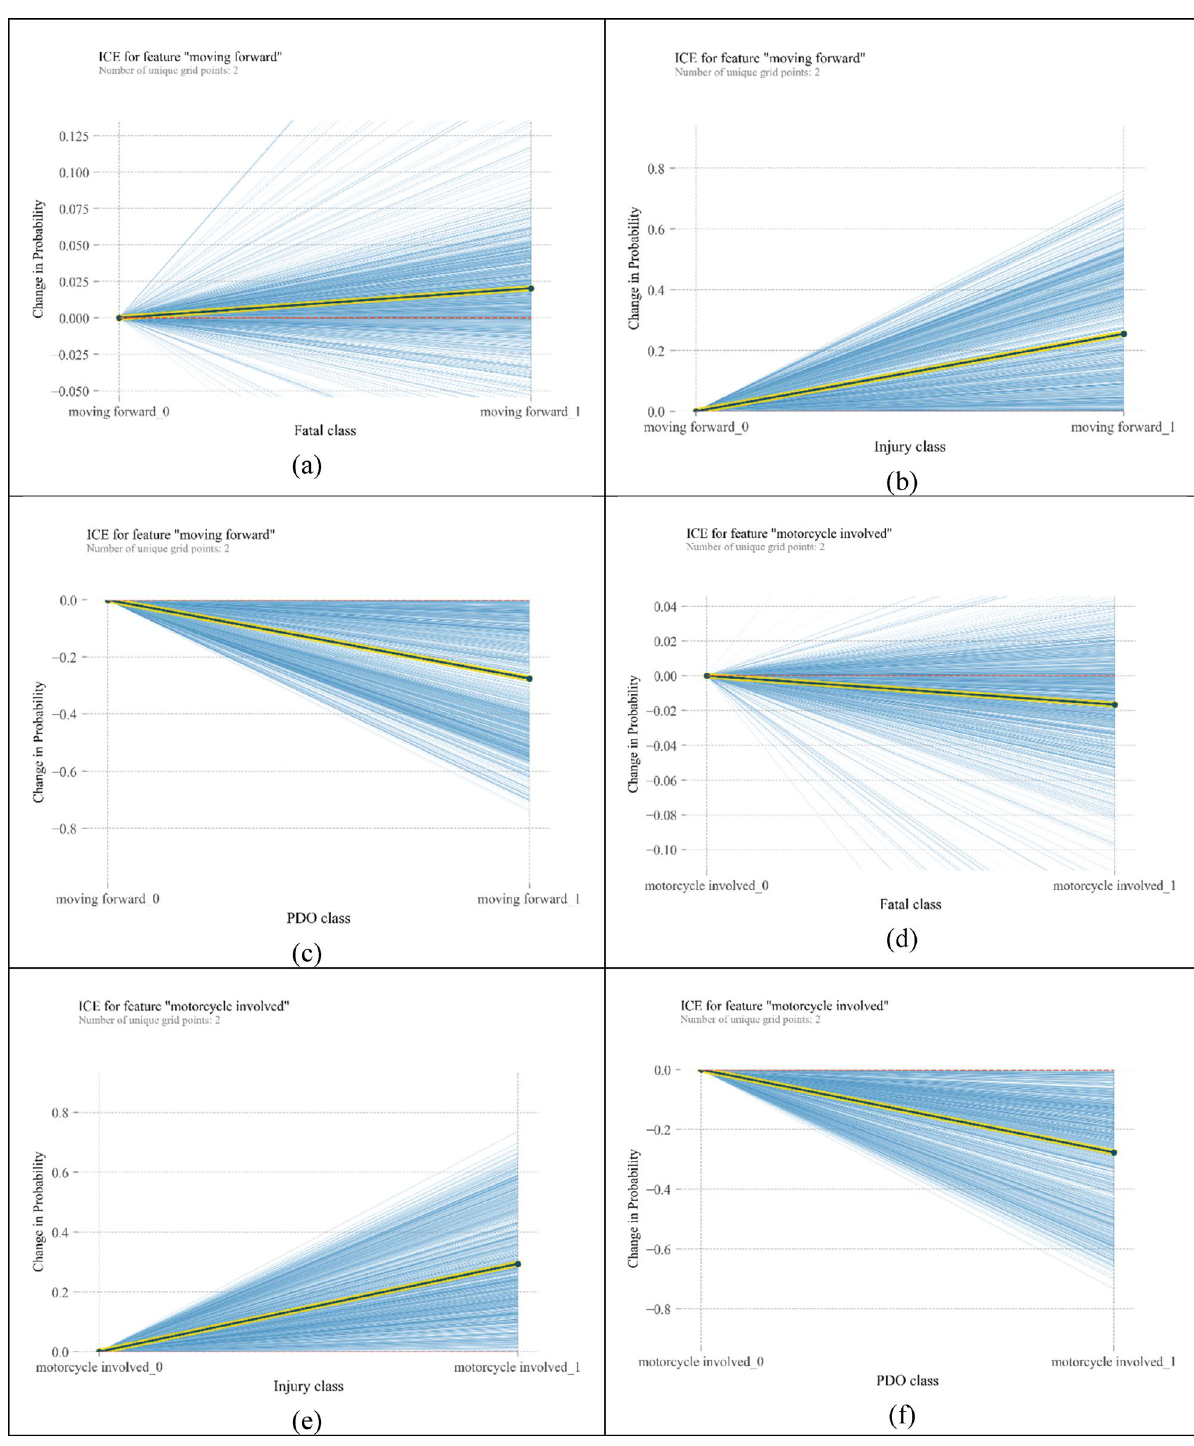
Figure 6. ICE plots for the most important variables [plotted by Python Matplotlib v. 3.3.4 https:// matpl otlib.